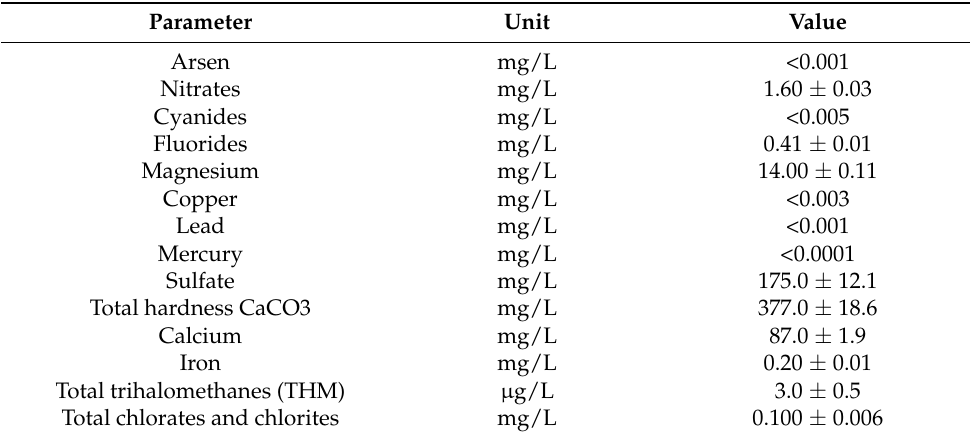
Table 2. Chemical composition of water used in the experiments.